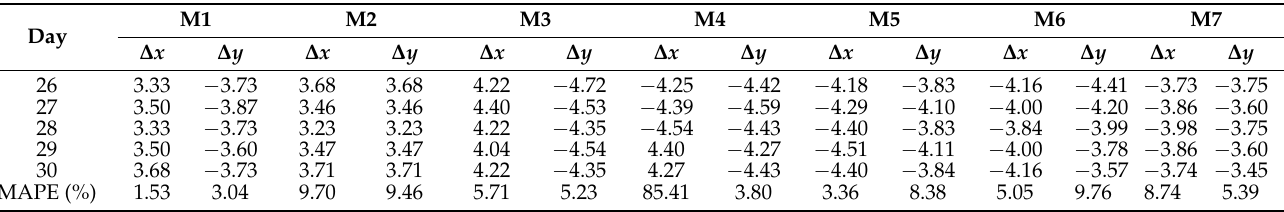
Table 28. Forecasted displacements for all markers